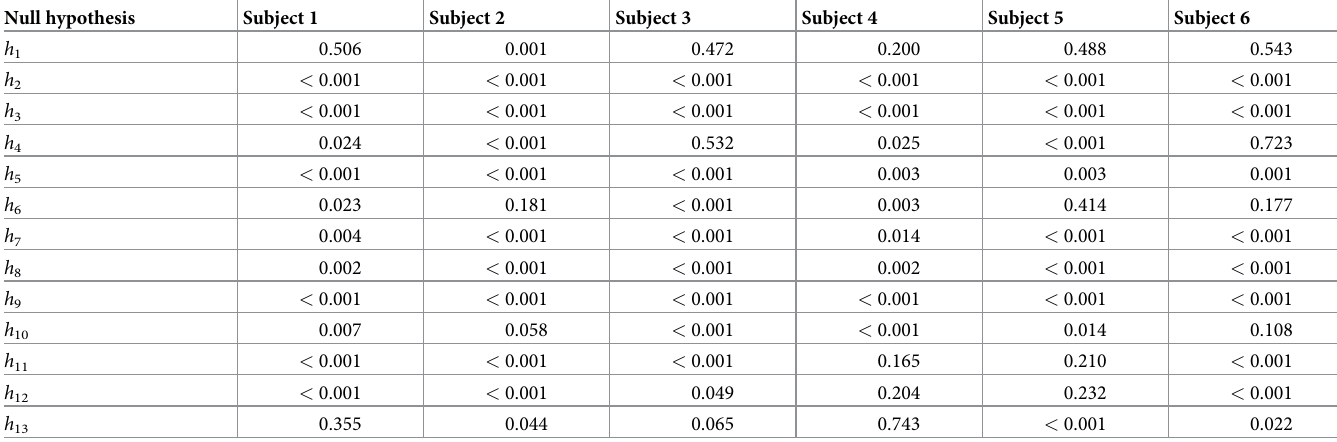
Table 3. P-values for null